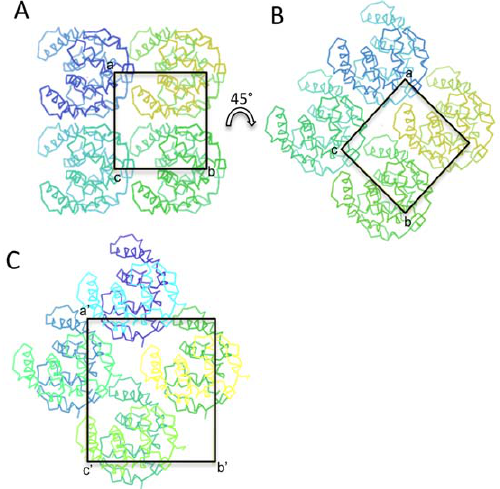
Figure 3. Two dimensional projection (along C axis direction) of 2-fold symmetry related molecules for space group P4 1 22 and C222 1 . The transformation between space groups P4 1 22 and C222 1 is illustrated. (A) The projection of Cthe_2751 monomer (dark blue) and 7 symmetry related molecules along C axis. The homodimer of Cthe_2751 (dark and light blue molecules) is related by crystallo- graphic 2-fold 2(x 0 0). Please note that 4 1 screw symmetry related molecules are not shown for the sake of only displaying the transformation between P4 1 22 and C222 1 space groups; (B) In order to illustrate the transformation between P4 1 22 and C222 1 space groups, Figure 3A is rotated 45 degrees clockwise around 4 1 axis; (C) The projection of Cthe_2751 dimer along C axis. The 4 Cthe_2751 dimers in